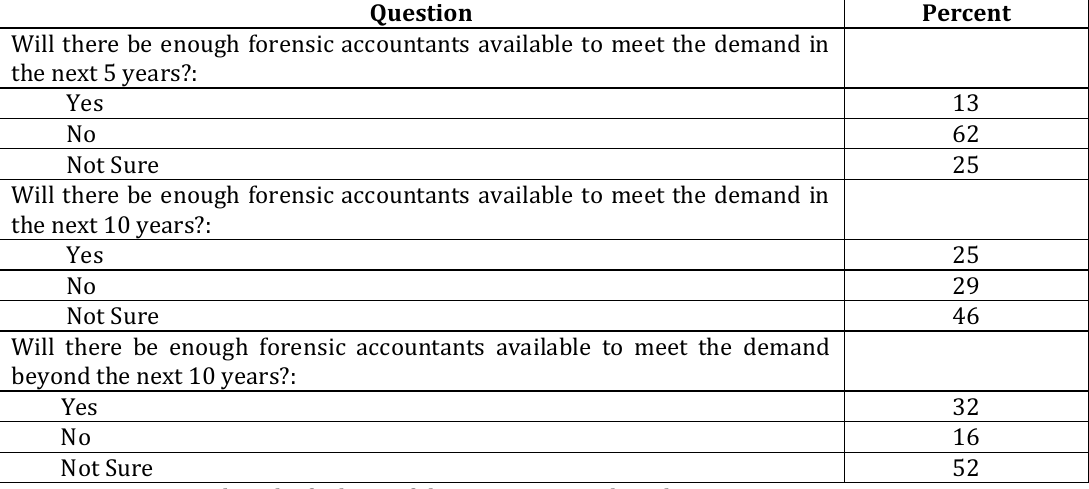
Table 17: Availability of Forensic Accountants in the Future Question